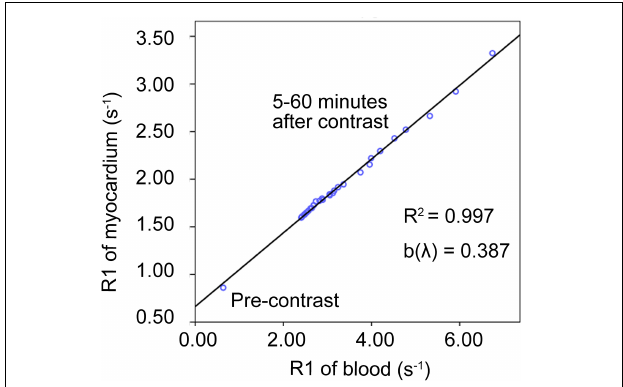
FIGURE 2 | Contrast agent distribution coefficient ( λ ). An example of the linear regression relationship between the myocardial R1 value and the blood R1 value before (0 min) and after enhancement (5–60 min) in one of the pigs. The data of pre-contrast shows the smallest R1 of myocardium and R1 of blood, while the data of 5 min shows the largest R1 of myocardium and R1 of blood. Within the observation time window between 5 and 60 min after the injection of the contrast agent, the R1 values of the ventricular septum and the left ventricular blood recover proportionally and become closer to the pre-contrast level from 5 to 60 min. The scatter plot demonstrates the validity of the linear regression model. The slope of the line was defined as the distribution coefficient of the contrast agent ( λ ).